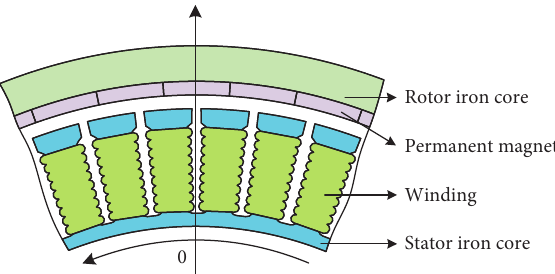
Figure 2: Structure of the outer-rotor PMBLDC